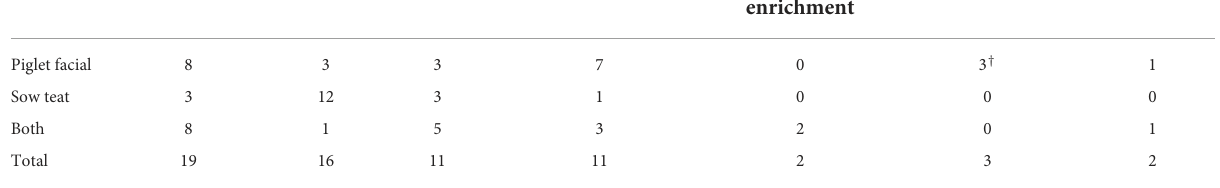
TABLE 2 The number of records found on each factor for piglet facial and sow teat lesions, or both. Lesion Teeth resection Housing Litter size Piglet management